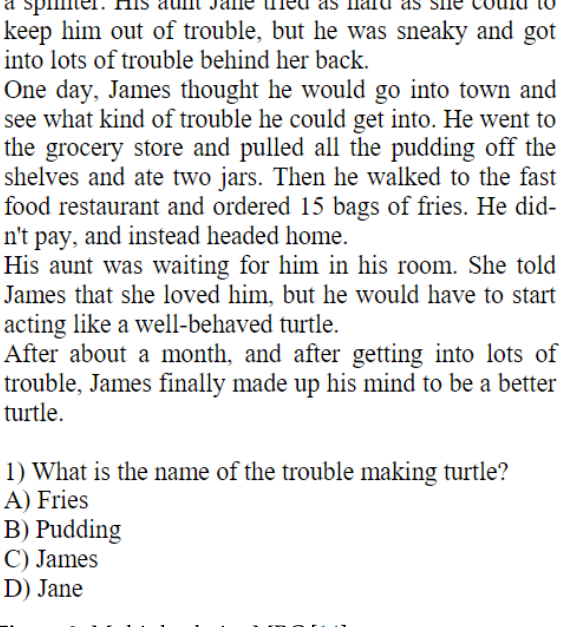
Figure 2. Multiple-choice MRC